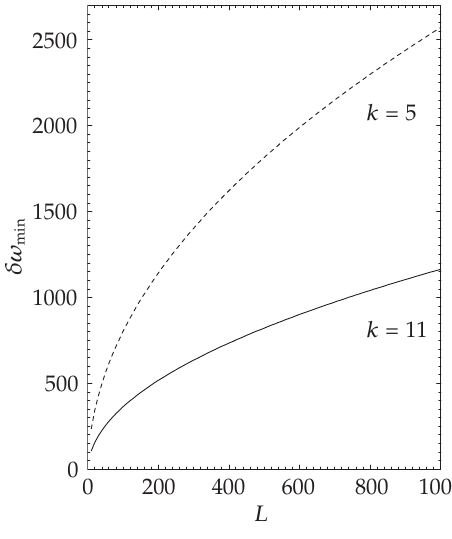
= δω ( see Figures A min